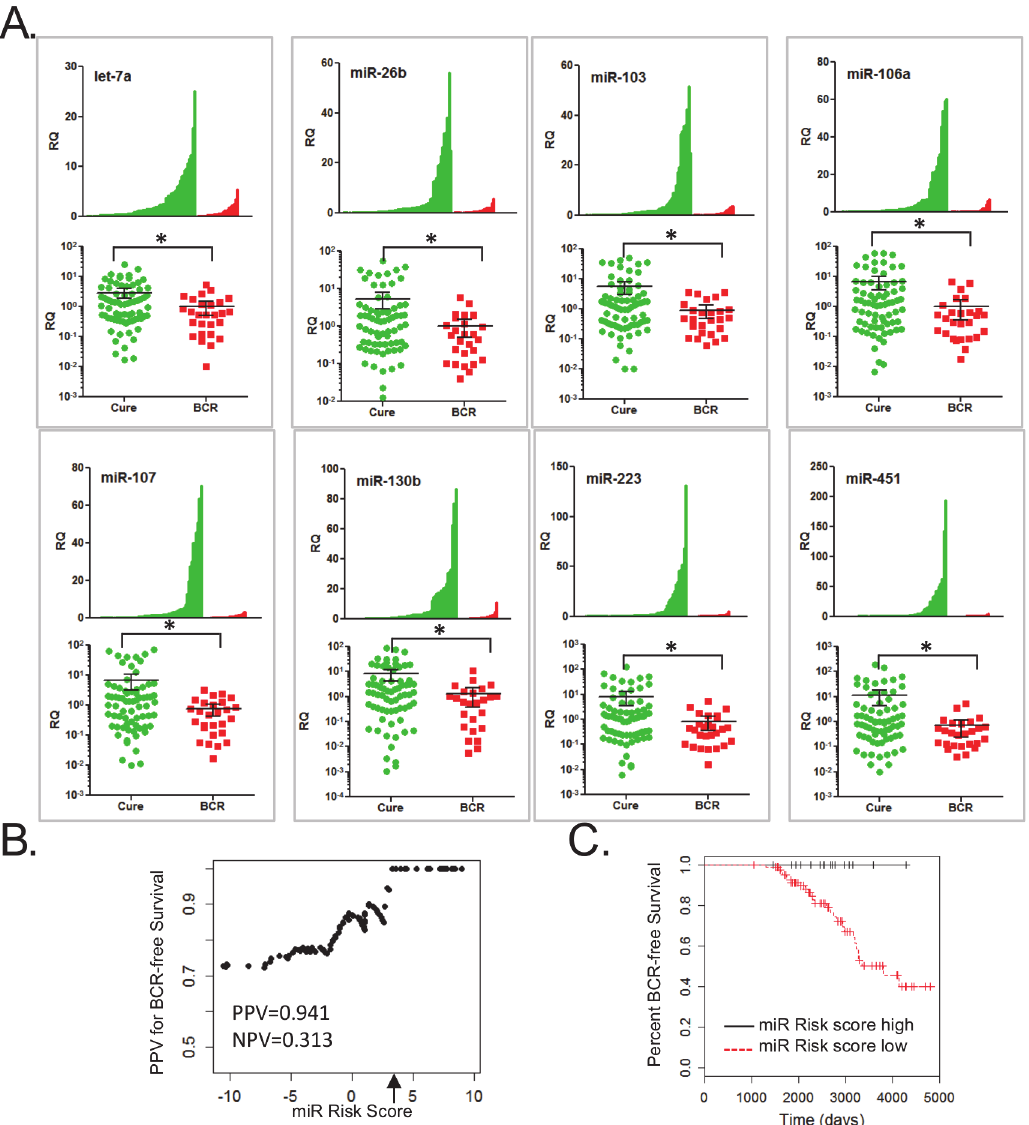
Fig 3. Circulating miRNAs levels in PCa patients correlate with BCR and predict disease-free survival. A, Waterfall (linear y-axis) and scatter (log10 y- axis) plots of let-7a, miR-26b, 103, 106a, 107, 130b, 223 and 451 levels measured by RT-qPCR in serum from all PCa patients (N = 100) grouped by cure or BCR. * p < 0.05 by Wilcoxon rank sum test. B, NPV for disease-free survival (no BCR) in the PCa patients only (N = 100) across the range of miR Risk Scores reaching NPV = 0.941 at the miR Risk Score of 3.26 (arrow). miR Risk Score = (0.223 x miR-451) + (0.225 x miR-106a) + (0.217 x miR-223) + (0.215 x miR- 107) + (0.147 x miR-130b) + (0.217 x of let-7a) + (0.196 x of miR-26b). C, Kaplan-Meier survival curve for all PCa patients (N = 100) above (high score) and below (low score) the miR Risk Score